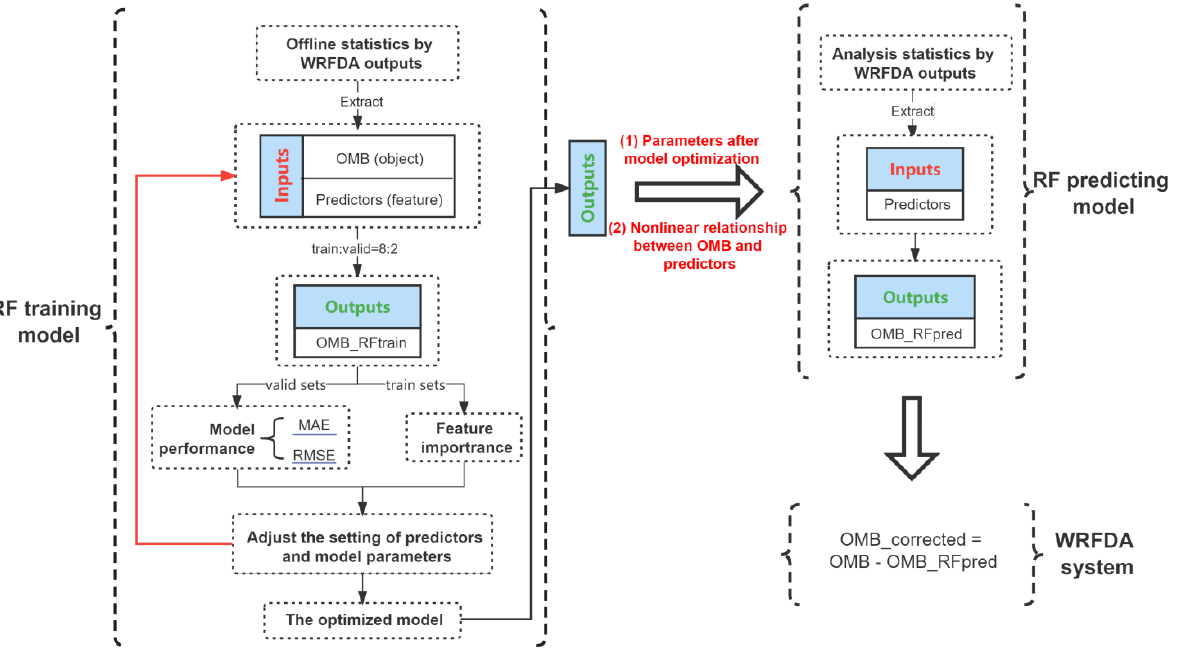
Figure 1. Flowchart of the RF model coupling with the WRFDA system for the bias correction of satellite radiances .